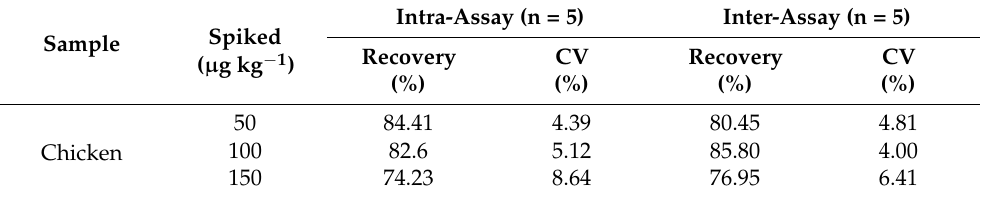
Table 3. Recovery studies from chicken muscle matrices using FPIA.